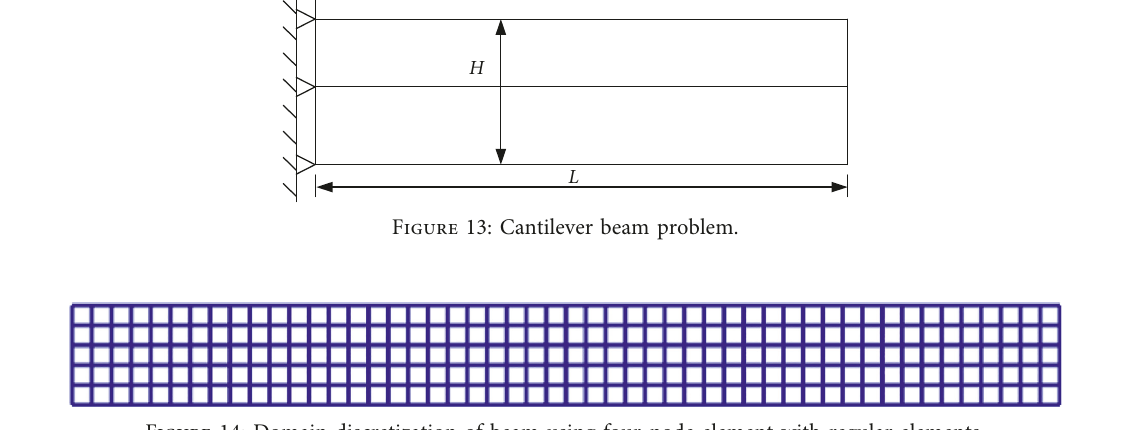
Table 3: First 12 natural frequencies (